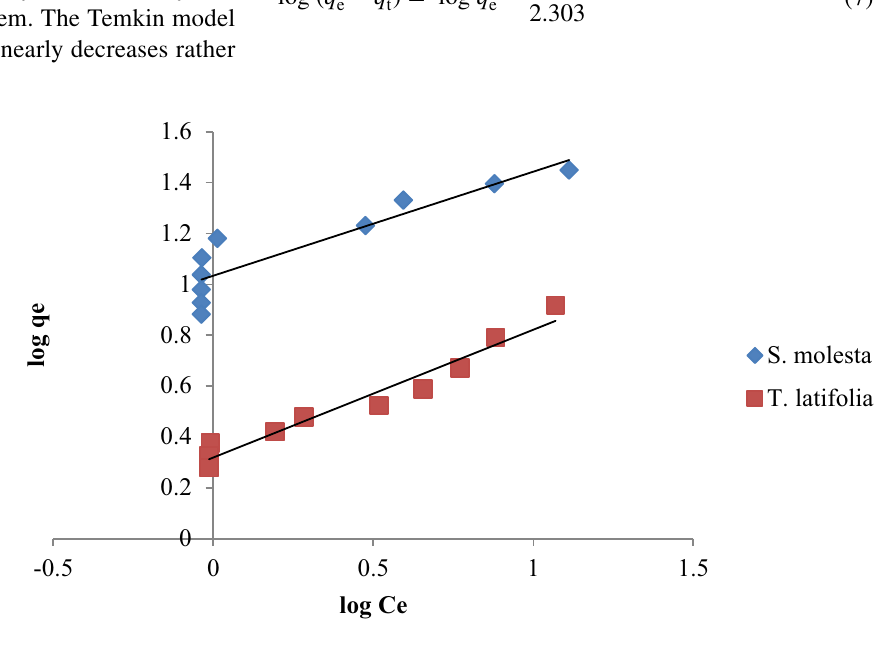
Fig. 11 Freundlich isotherm plot for Cr 6+ adsorption on S. molesta and T.